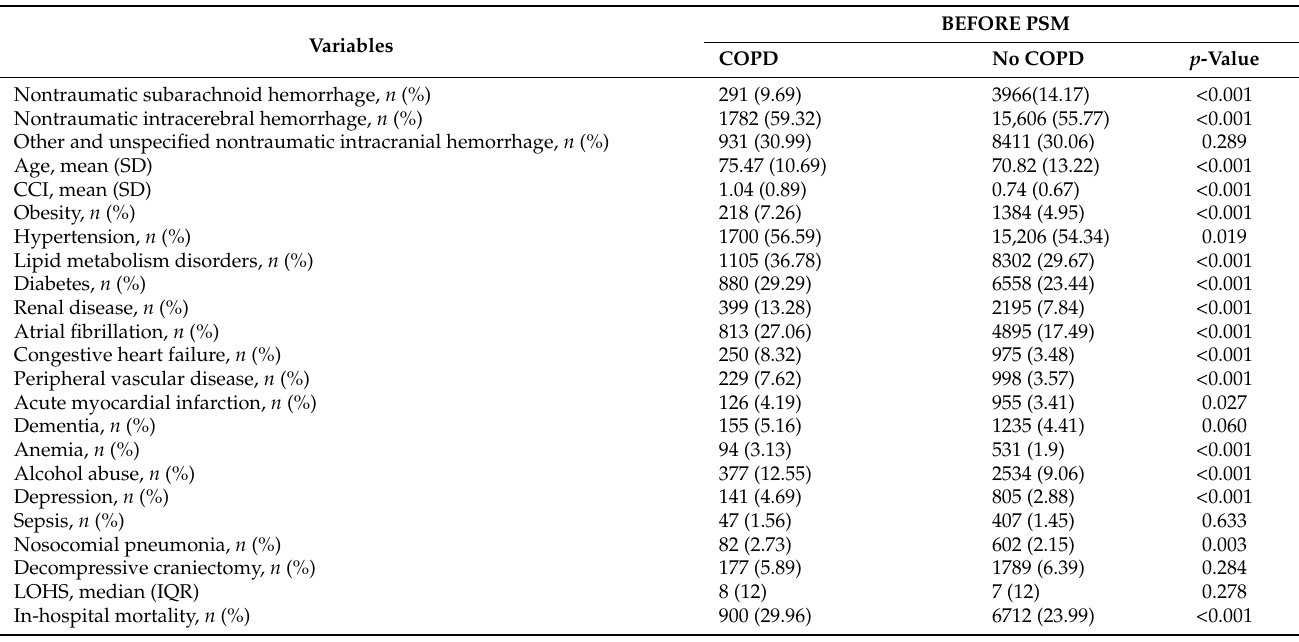
Table 2. Clinical characteristics, use of therapeutic procedures and hospital outcomes before propensity score matching in men patients with hemorrhagic stroke.